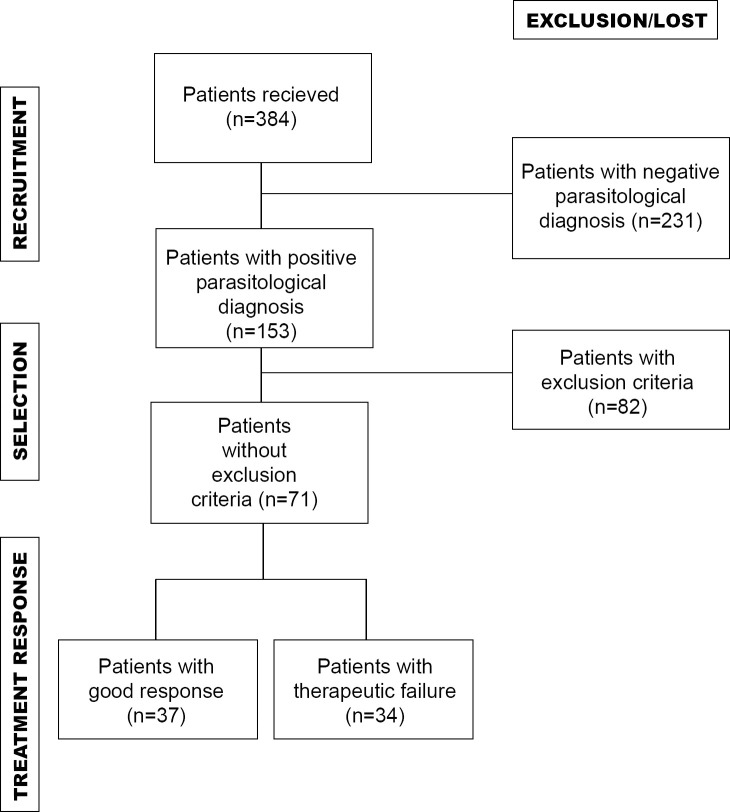
Flowchart of selection and response to treatment among evaluated patients.